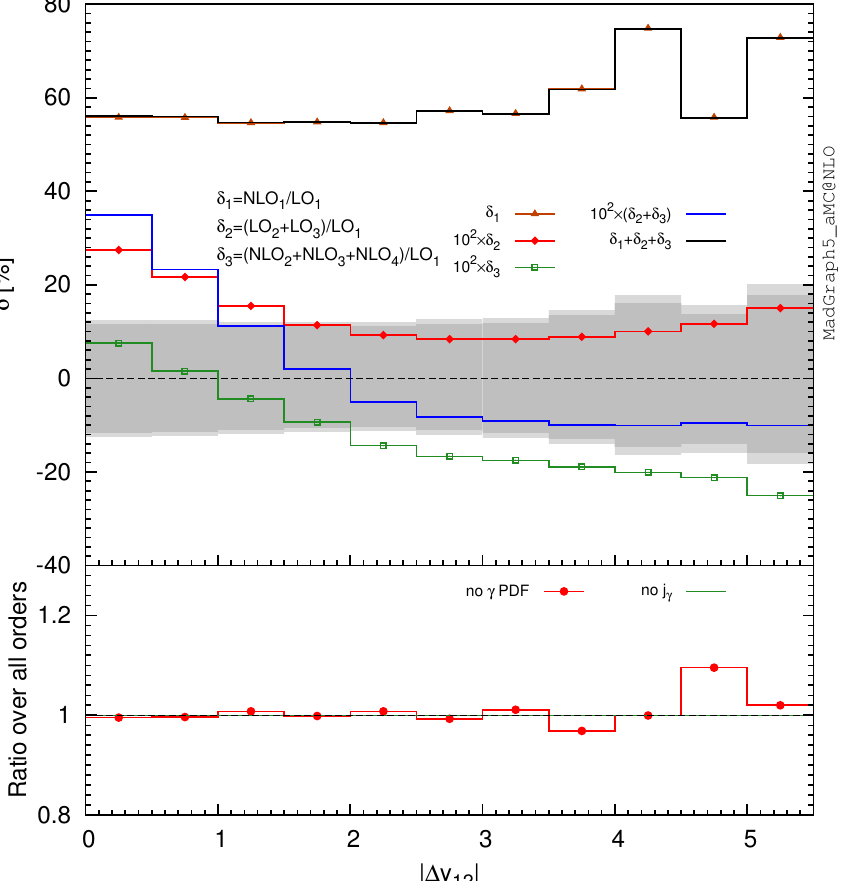
Figure 14 . Rapidity distance between the two hardest